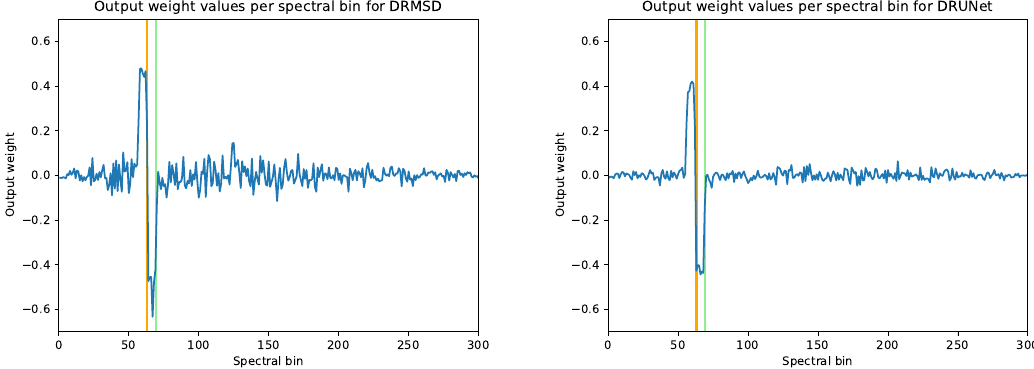
Figure 18. Data reduction weights per bin after training with DRMSD ( a ) and DRUNet ( b ) on the noisy few-material X-ray dataset. The K-edge of the material of the objects to be detected (silver) is located between bins 63 and 64 (indicated in orange), which is the location of the drop. The K-edge of cadmium is indicated in green. Additionally, note that the absolute value of the weights decreases when approaching bin 1 or